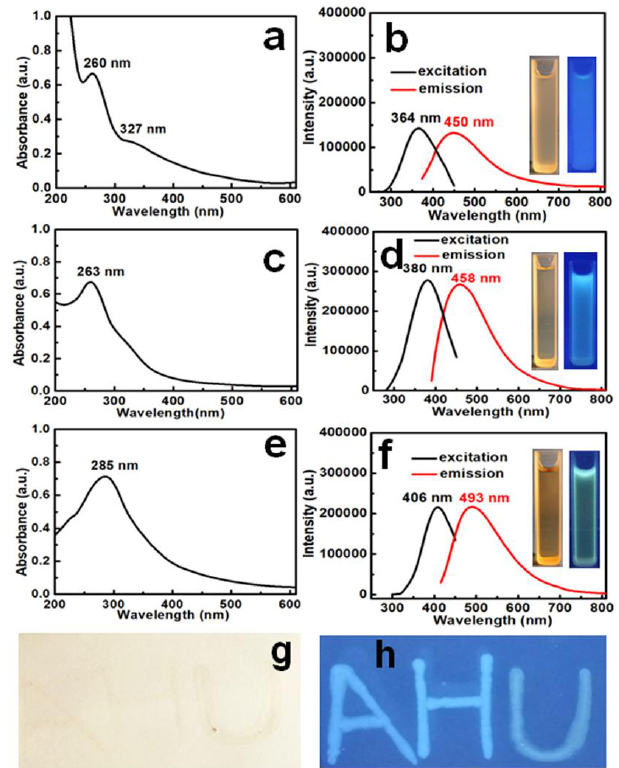
Figure 3. ( a , c , e ) UV–VIS absorption spectra and ( b , d , f ) optical excitation and emission spectra of ( a , b ) CQDs-90, ( c , d ) CQDs-120 and ( e , f ) CQDs-150. ( g , h ). Digital photographs of the handwritten letters of “AHU” on the filter paper radiated under daylight and UV light (365 nm), respectively. The insets in panels ( b , d , f ) for the corresponding photographs taken under daylight ( left ) and 365 nm UV light ( right ).